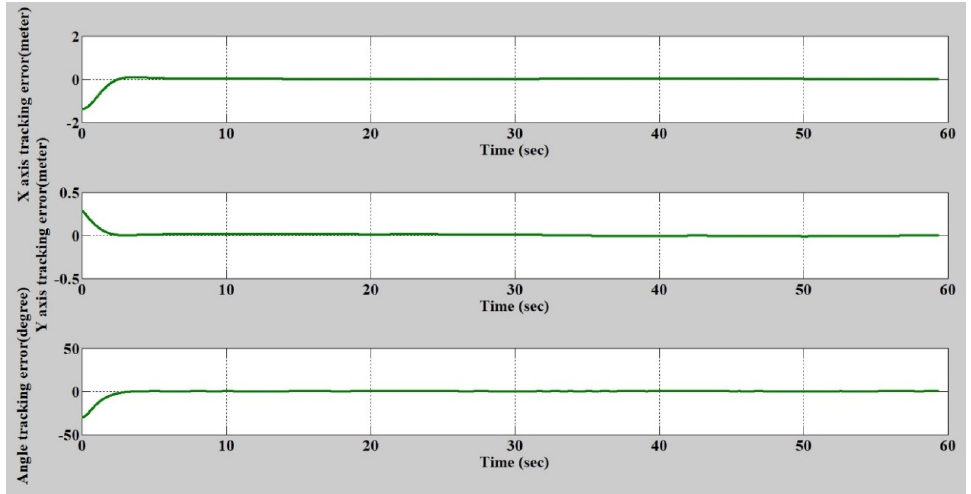
Figure 4. Results of circular trajectory tracking errors concerning initial point ( x c = − 1.9 m, y c = 0 m).